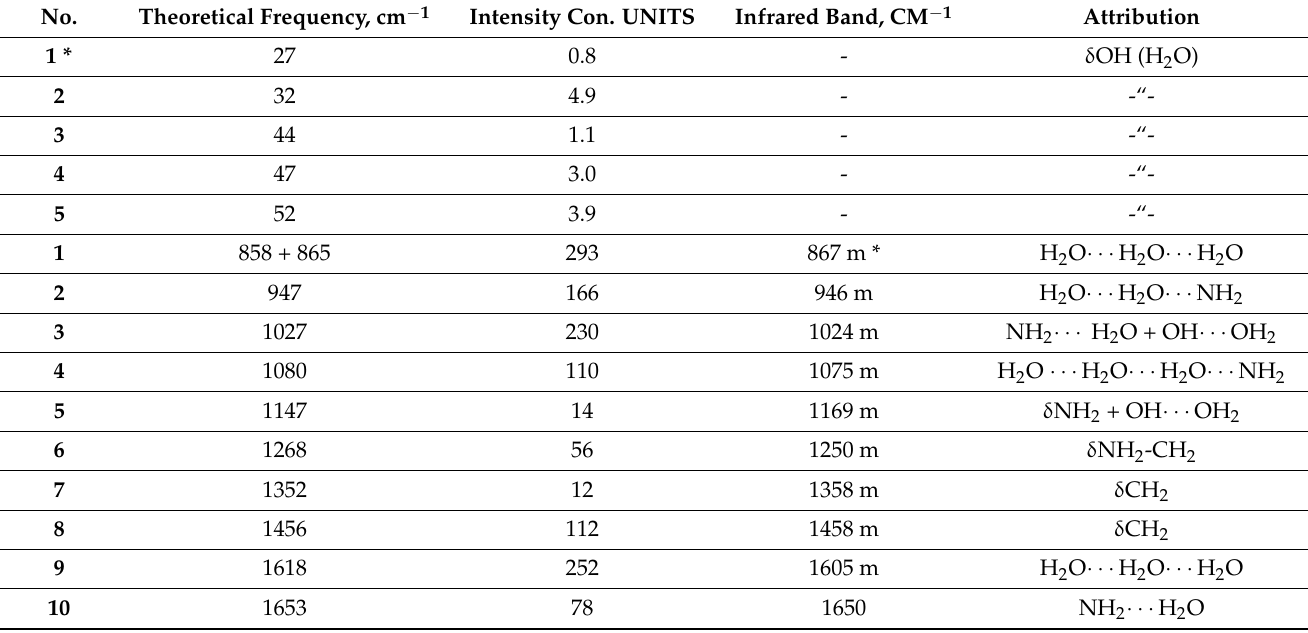
Table 3. Comparison of theoretical frequencies of associate-complex MEA-10H 2 O with the experi- mental spectra (Figures 7 and 8) and their attribution.